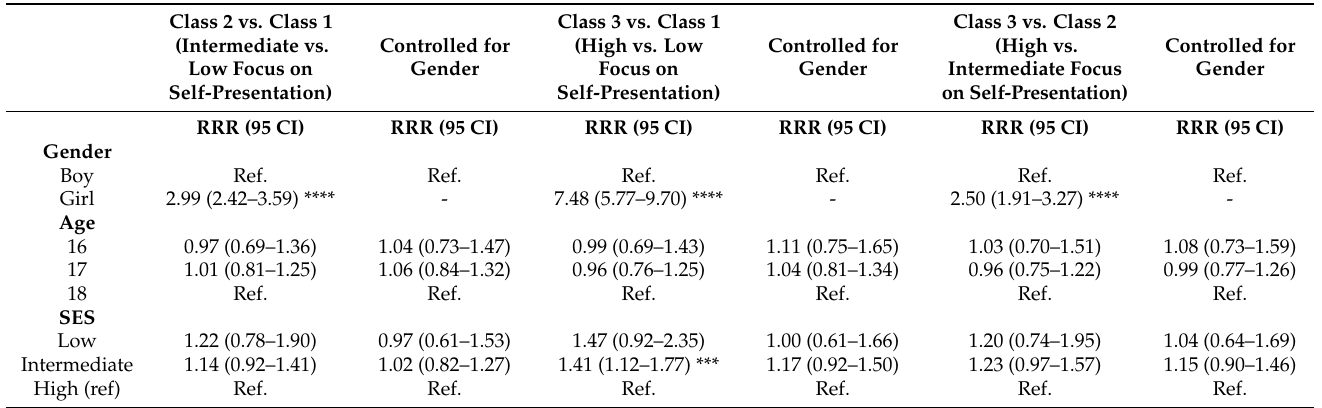
Table 5. Comparison of class belongingness across sociodemographic variables.